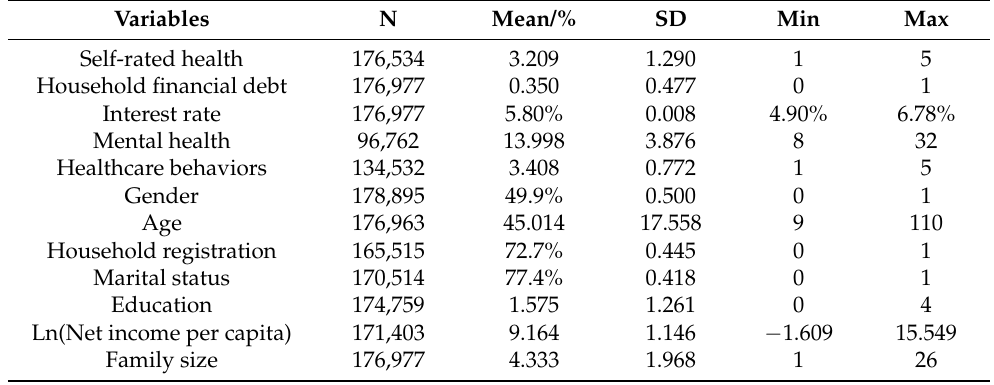
Table 1. Descriptive statistics.